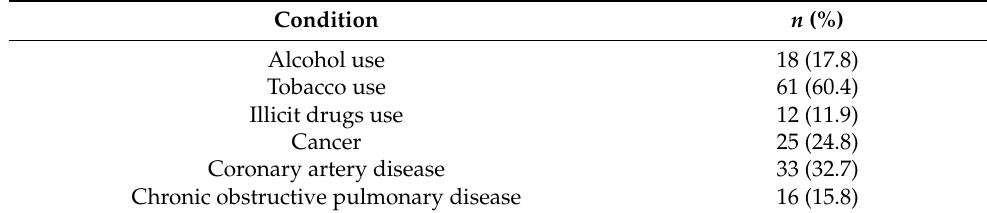
Figure 1. Paired frequency distribution and percent change in ECG rhythms before and after initiation of empagliflozin in 78 patients. ECG: electrocardiograpm; SVT: Supraventricular tachycardia; STD: ST segment depression; STE: ST segment elevation; SB: Sinus bradycardia; PVC: Premature ventricular contraction; TWa: T wave abnormalities; AFL: Atrial flutter; Afib: Atrial fibrillation; ST: Sinus tachycardia; LBBB: Left bundle branch block; AVB: Atrioventricular block; RBBB: Right bundle branch block; PAC: Premature atrial contraction. Table 1. Summary of patient comorbid